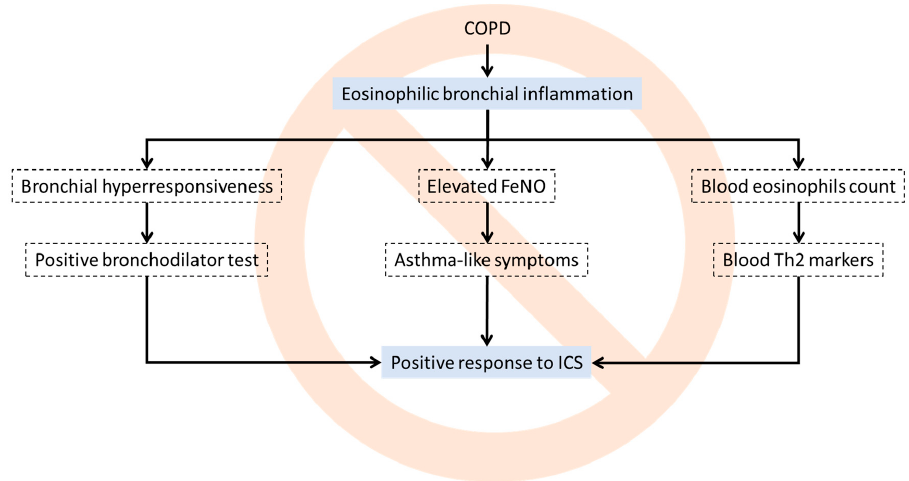
Figure 1. Some erroneous associations that clinicians frequently make when evaluating COPD patients.